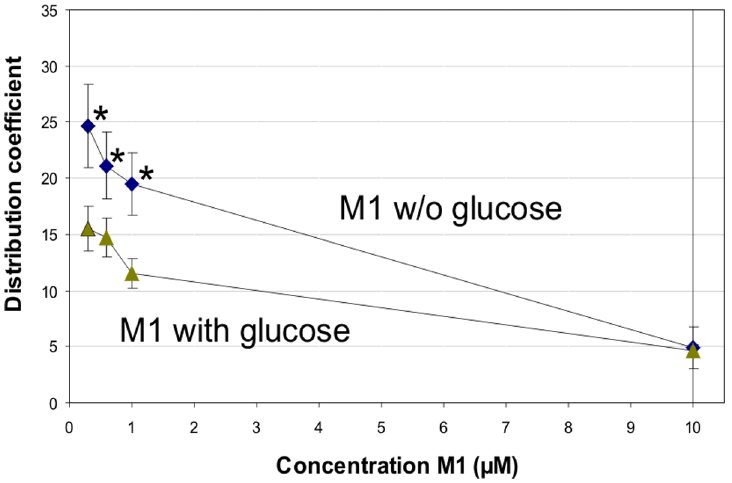
Figure 3. Distribution of M1 into human erythocytes. Increasing concentrations of the metabolite M1 were incubated in the absence and presence of glucose (100 mM) with human erythrocytes (hematocrit 0.043) at 4 u C. The reaction was stopped after one minute with phloretin (200 m M) and cytochalasin B (20 m M). For 0.3 to 1 m M M1 the uptake into erythrocytes was statistically significant higher in absence of glucose compared to the respective uptake (0.3 to 1 m M M1) in the presence of glucose (p , 0.05) and also compared to the uptake of 10 m M M1 (p , 0.001; one-way ANOVA with Bonferroni post-hoc test). Each data point represents the mean and mean deviation of the mean of six replicates.